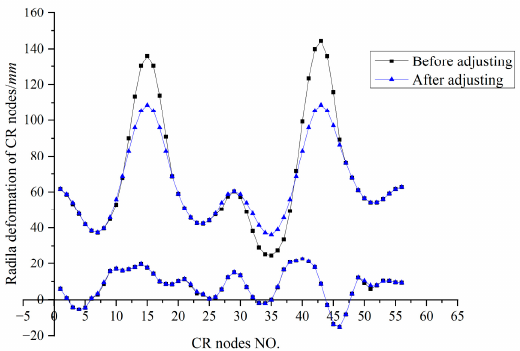
Figure 43. Envelope diagram of CR radial deformation before and after adjusting.